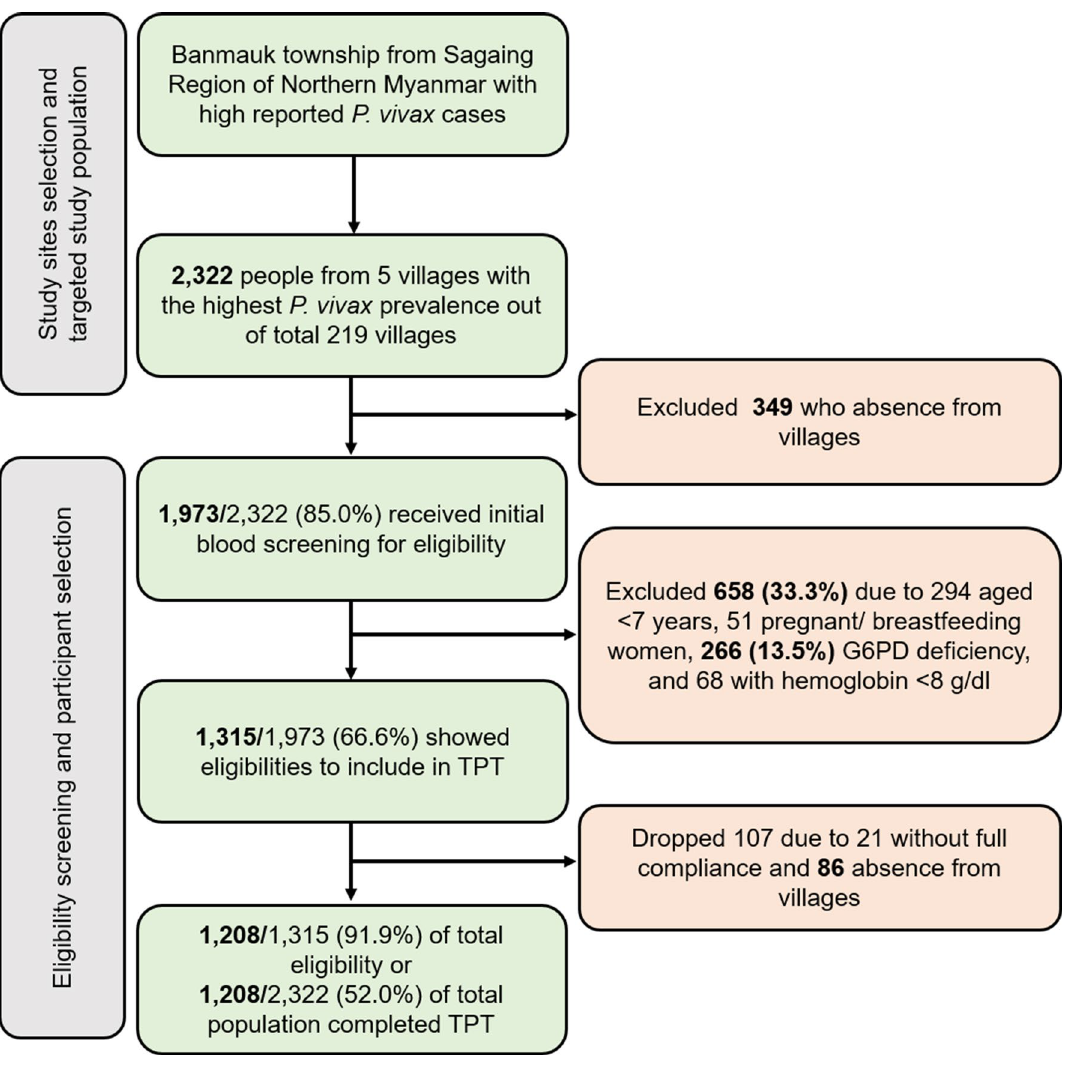
Figure 2. Schematic diagram for population screening for targeted primaquine